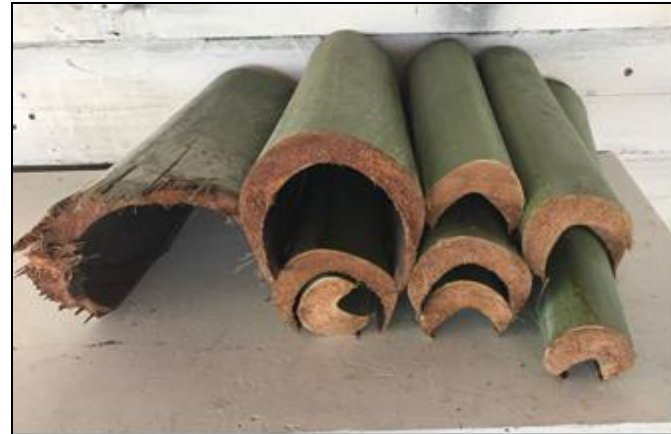
Figura 2: Palmeira de buriti coletada e lavada previamente. Fonte: Autores, (2018).